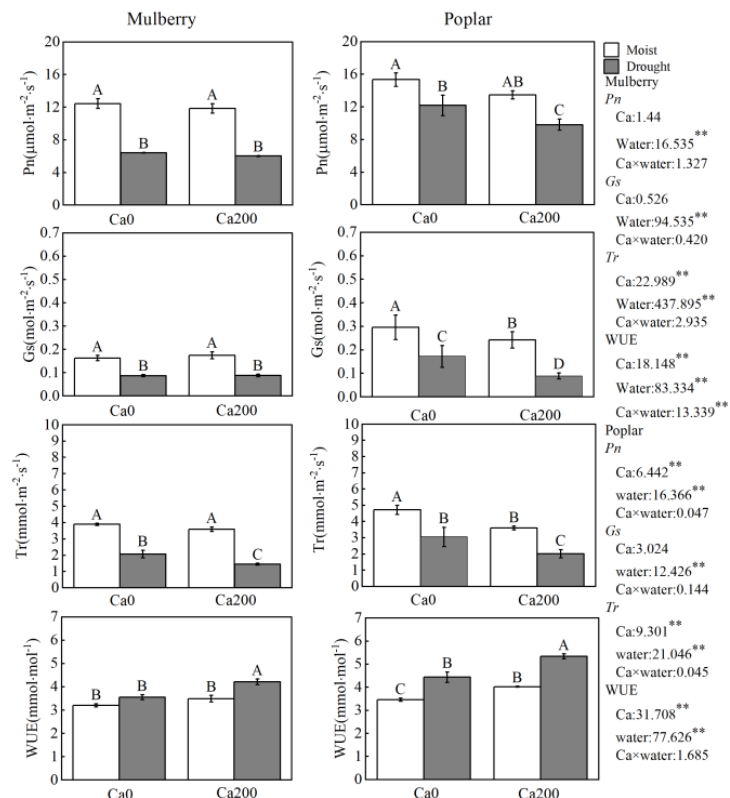
Figure 1. Effects of water and Ca treatments on photosynthetic parameters of the two species. Different letters indicate significant differences ( p < 0.05) among treatments. Treatment values shown as mean ± SE (n = 6). Results of two − way ANOVA addressing effects of Ca and water treatments are summarized on the right side. ** indicate that the F value is significant at 0.01.